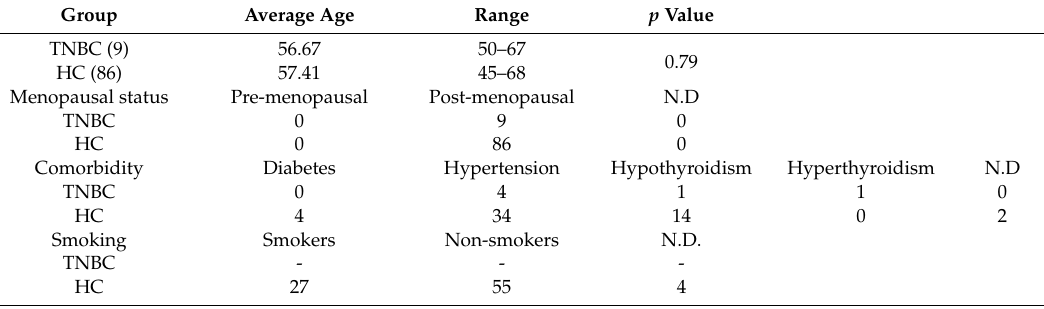
Table 1. Medical and demographic information about patients enrolled in the